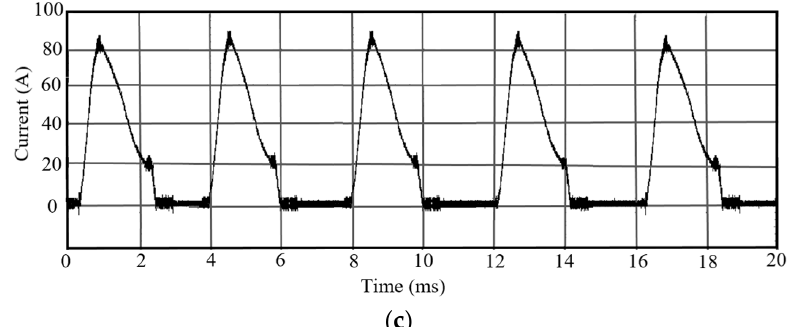
Figure 13. Current waveforms with same rotational speed and different load torques. ( a ) Current waveform with 4 N·m load torque. ( b ) Current waveform with 8 N·m load torque. ( c ) Current waveform with 12 N·m load torque.